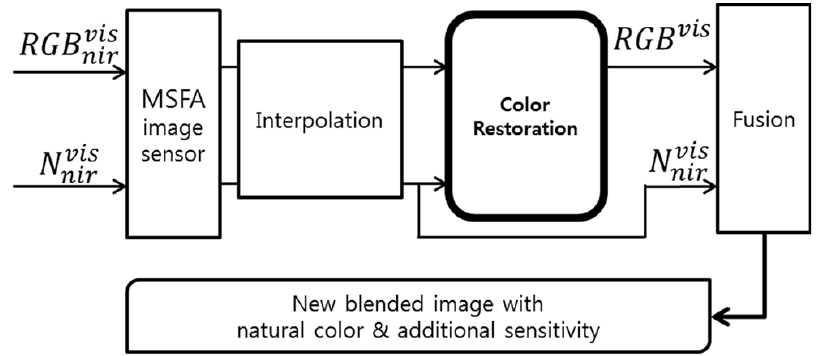
Figure 3. Example of a multispectral filter array (MSFA)-based imaging